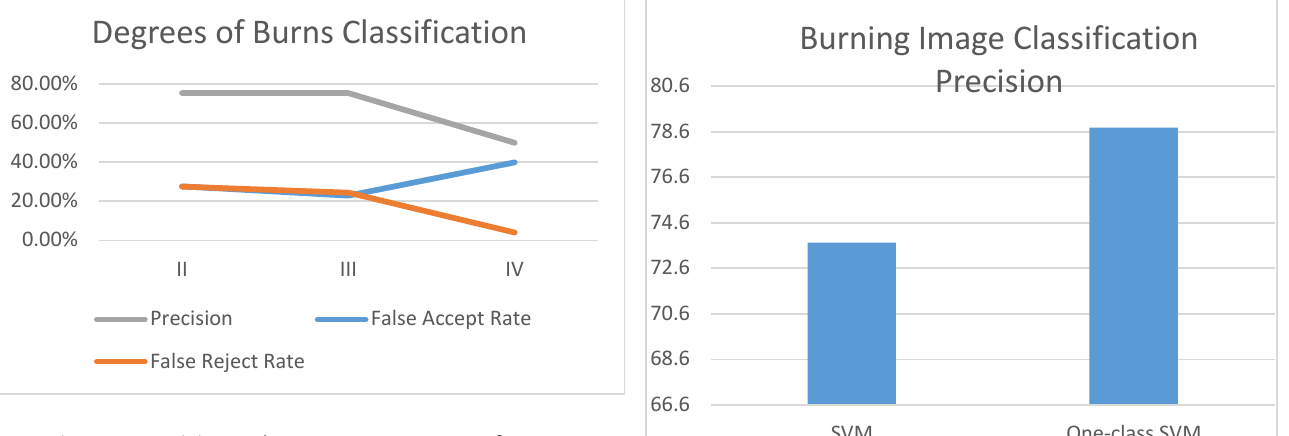
Fig. 18. Precision and FAR- FRR Degrees of Burn Identification results